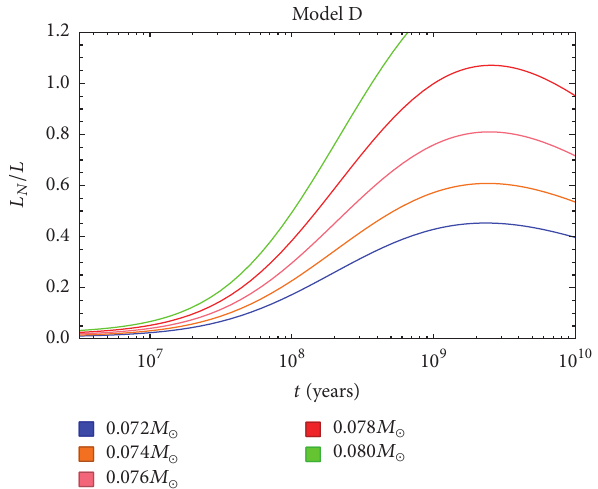
Figure 4: The variation of 𝐿 𝑁 /𝐿 over time 𝑡 for different masses for model D in Table 1.